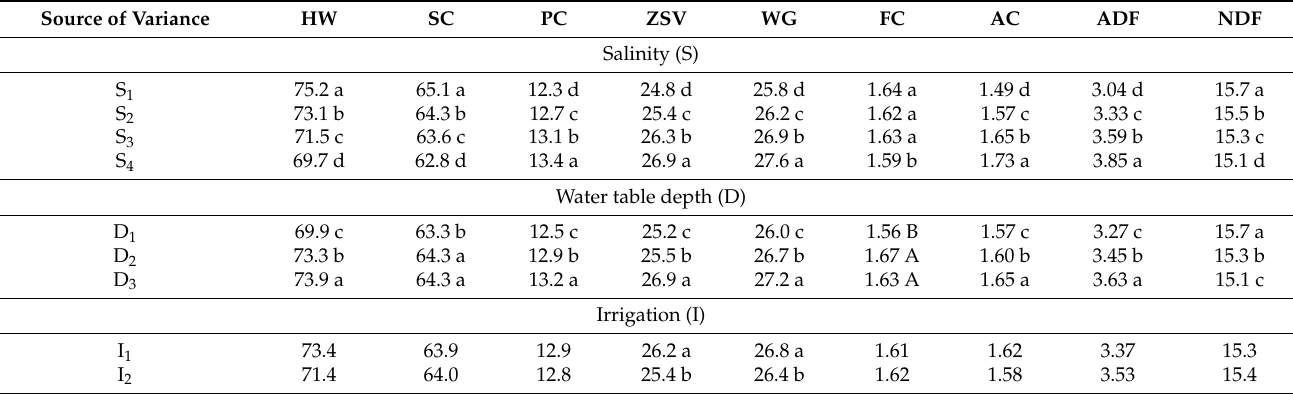
Table 4. The mean of the two years for the effects of the four salinity levels, three water table depths, and two irrigation levels on the wheat parameters *.